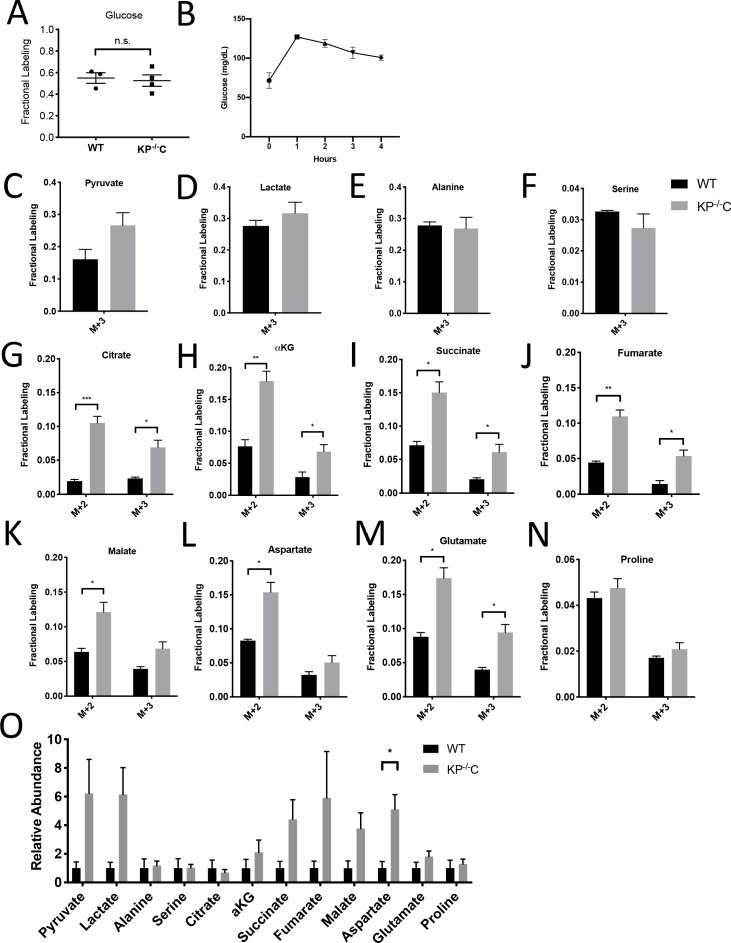
Glucose metabolism in autochthonous PDAC tumors infused with U-13C- glucose at 30 mg/kg/min.(A) Enrichment of fully labeled glucose (M+6) in plasma from the indicated mice following a 4 hr U-13C-glucose infusion at a rate of 30 mg/kg/min. Non-tumor bearing C57Bl6/J (WT) mice were used to assess metabolite labeling in normal pancreas. WT, n = 3; KP-/-C, n = 4. Differences in plasma glucose enrichment were not significant between WT and KP-/-C tumor-bearing mice (p=0.7600) based on an unpaired student’s t test. Mean +/- SEM is shown. (B) Plasma glucose levels over time in tumor-bearing KP-/-C mice infused with U-13C-glucose at a rate of 30 mg/kg/min. n = 4. Mean +/- SEM is shown. (C–N) The fractional labeling of pyruvate (C), lactate (D), alanine (E), serine (F), citrate (M+2 p=0.0008, M+3 p=0.0155) (G), α-ketoglutarate (αKG) (M+2 p=0.0038, M+3 p=0.0398) (H), succinate (M+2 p=0.0098, M+3 p=0.0334) (I), fumarate (M+2 p=0.0018, M+3 p=0.0138) (J), malate (M+2 p=0.0208) (K), aspartate (M+2 p=0.0097) (L), glutamate (M+2 p=0.0058, M+3 p=0.0115) (M), and proline (N) in WT normal pancreas (black) and autochthonous pancreatic tumors (grey) from LSL-KrasG12D/+; Trp53fl/fl ; Pdx1-Cre (KP-/-C) mice following a 4 hr U-13C-glucose infusion at a rate of 30 mg/kg/min. Non-tumor bearing C57Bl6/J (WT) mice were used to assess metabolite labeling in normal pancreas. The M+2 and M+3 isotopomers are shown for each metabolite: pancreas, n = 3; tumor, n = 4. Significance was based on unpaired, Students t-test. Mean +/- SEM is shown. (O) Relative abundance of tumor metabolites in WT normal pancreas (black) and autochthonous pancreatic tumors (grey) from LSL-KrasG12D/+; Trp53fl/fl; Pdx1-Cre (KP-/-C) mice following a 4 hr U-13C-glucose infusion at a rate of 30 mg/kg/min. Total ion counts were first normalized to tissue weight and norvaline abundance as an internal control, and then WT pancreas values were set to 1. Differences were significant based on unpaired, Students t-test for aspartate (p=0.0171). pancreas, n = 3; tumor, n = 4. Mean +/- SEM is shown.Figure 1—figure supplement 2—source data 1.Isotope labeling of tumors in U-13C- glucose-infused mice with autochthonous PDAC tumors presented in Figure 1—figure supplement 2.